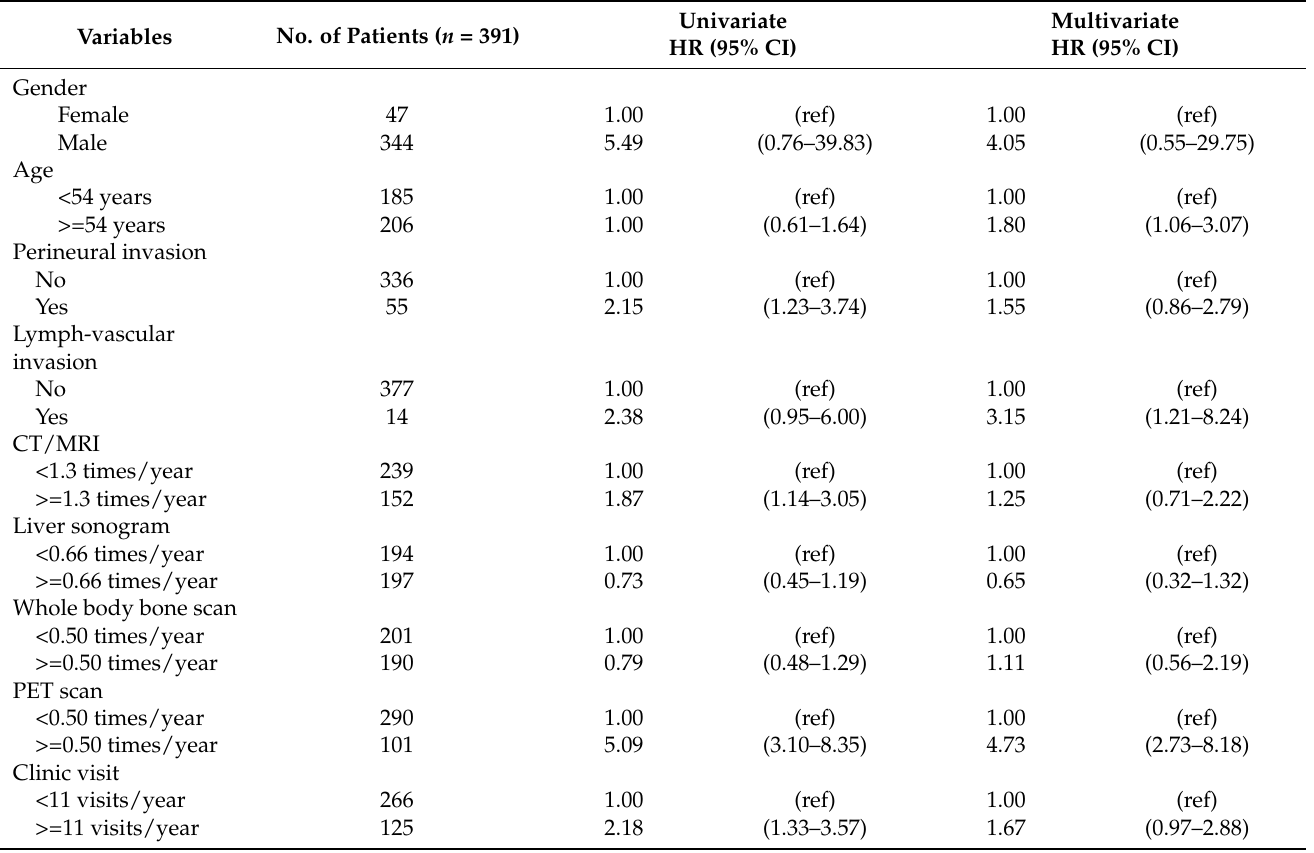
visits were significant prognostic factors in the multivariate analysis of elder patients (Table 7). Our study found most of the patients with second primary were 54 years or older in the current study (>=54 years: 85 out of 393, 21.6% vs. <54 years: 51 out of 348, 14.7%, respectively, p = 0.019). In addition, most of the loco-regional recurrence was found in late-stage patients (early-stage: 87 out of 391, 22.3% vs. late-stage: 146 out of 350, 41.7%, respectively, p < 0.001) Table 4. Factors associated with disease-specific survival in early-stage oral cavity cancer patients. Variables